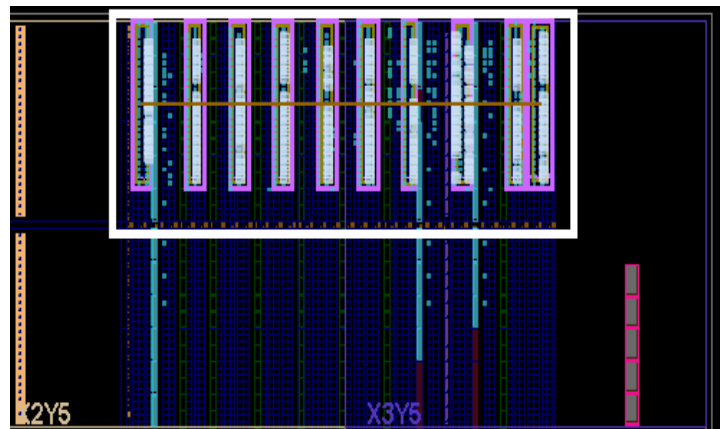
Figure 15. Floorplanning and static routing (reconfigurable area) of the physical neurons in case of the MNIST dataset .